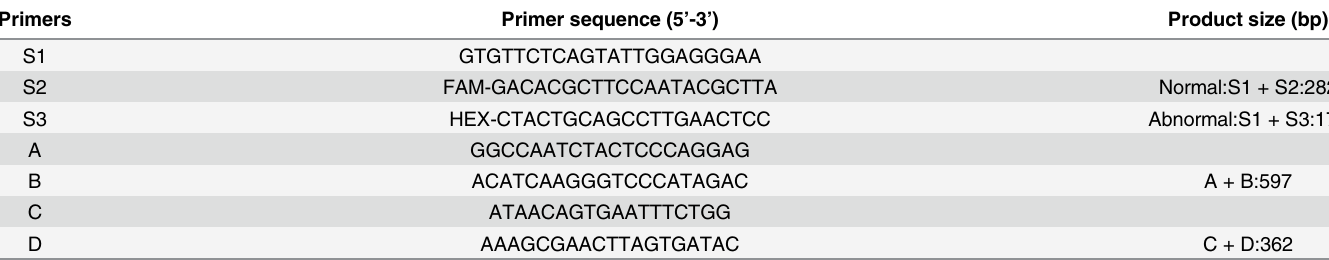
Table 1. Primer sequences and products sizes for detecting α - and β -thalassemia.